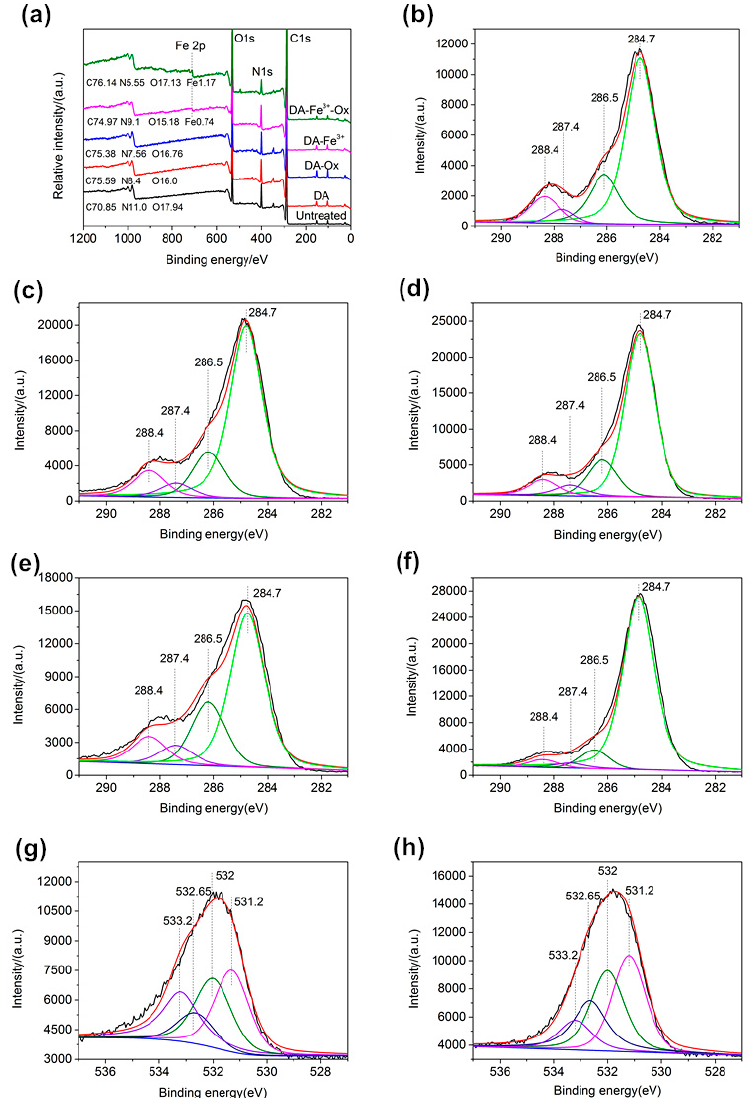
Figure 6. XPS spectra of wide scan spectra ( a ), C1s (( b ) untreated, ( c ) DA, ( d ) DA–Ox, ( e ) DA–Fe 3+ and ( f ) DA–Fe 3+ –Ox), and O1s (( g ) DA–Fe 3+ and ( h ) DA–Fe 3+ –Ox). ( f ) DA–Fe 3+ –Ox), and O1s (( g ) DA–Fe 3+ and ( h ) DA–Fe 3+